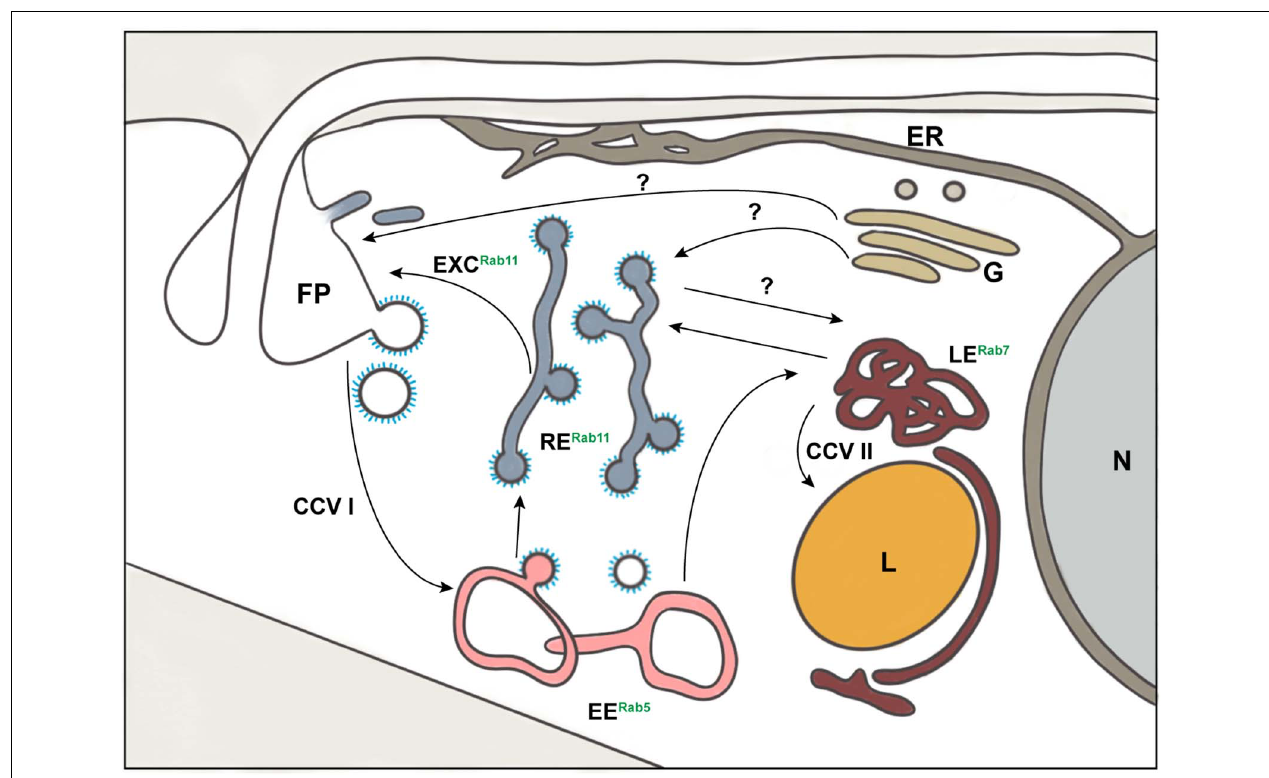
FIGURE 1 | Schematic representation of exo- and endocytic pathways in Trypanosoma brucei . The known organelles involved in the processes of exo- and endocytosis in T. brucei are depicted: class I clathrin-coated vesicles (CCV I), class II clathrin-coated vesicles (CCV II), early endosomes (EE), endoplasmic reticulum (ER), exocytic carrier (EXC), flagellar pocket (FP), Golgi apparatus (G), lysosome (L), late endosomes (LE), nucleus (N), and recycling endosomes (RE). The endocytic compartment is marked by the presence of small GTPases of the Rab family: Rab5 (EE), Rab7 (LE), and Rab11 (RE). The arrows represent the direction of exo- and endocytic cargo of T. brucei . The question marks indicate pathways that may exist but are still